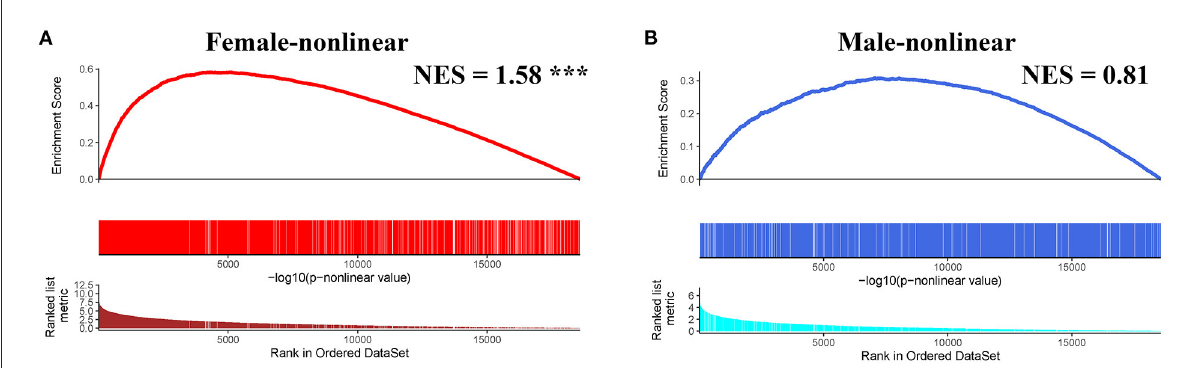
FIGURE4 GSEA analysis of subgroup-specific differentially expressed genes. (A) The enrichment plot illustrates that most subgroup-specific genes had a significantly non-linear relationship with female age. The normalized enrichment score (NES) and FDR ( *** < 0.001) in the female group. (B) The enrichment plot illustrates that most subgroup-specific genes had a significantly non-linear relationship with male age. The normalized enrichment score (NES) is shown without significant difference ( FDR >